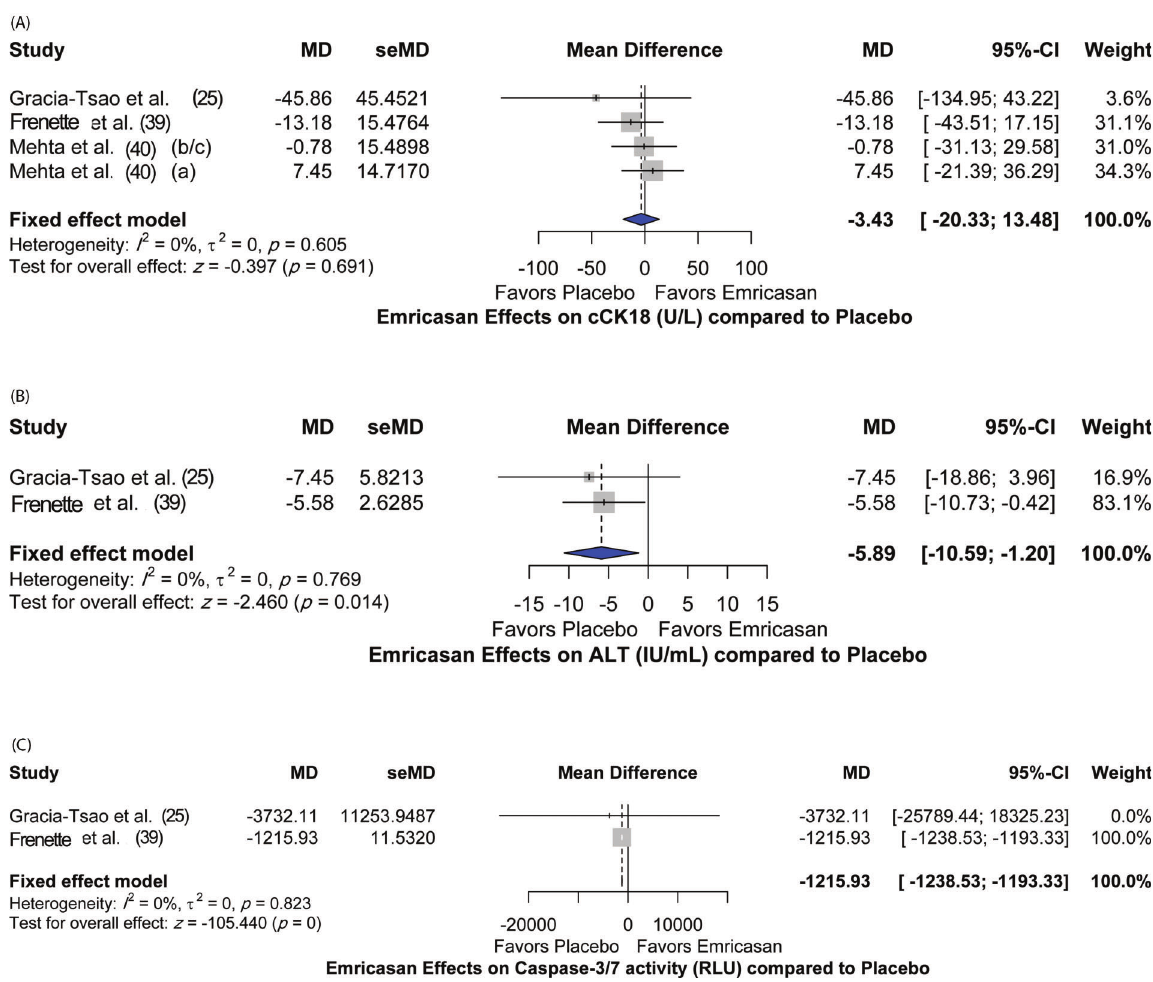
Figure 4 - Other measures of Emricasan efficacy compared to placebo. (A) Cleaved cytokeratin 18; (B) Alanine aminotransferase (IU/mL); (C) Caspase 3/7 activity (RLU): a=5 mg; b=25 mg and c=50